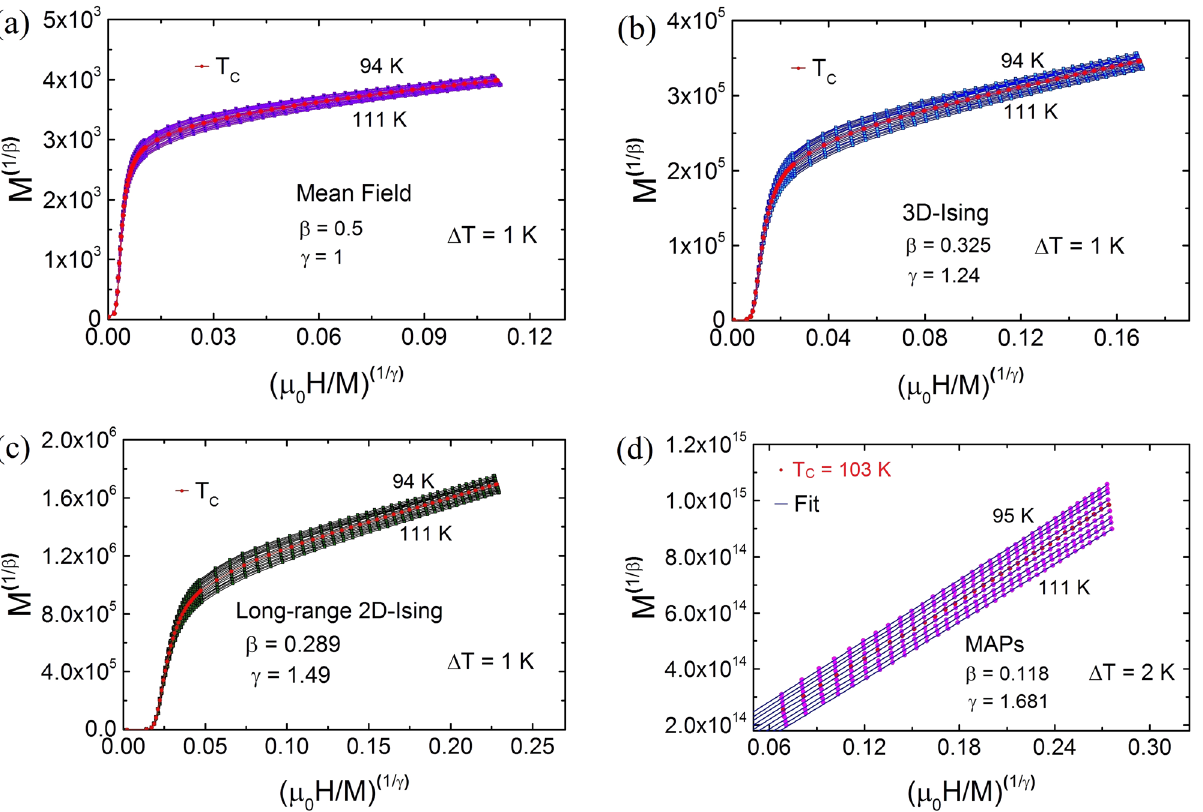
Figure 4. Isotherms of M 2 vs. µ 0 H/M for 94 K ≤ T ≤ 111 K ( | ǫ | ≤ 0.1 ) with ( a ) the Arrott plot (mean-field theory), which shows non-linear or non-mean-field type behavior even in higher magnetic field with positive slopes corresponding to the second-order phase transition. ( b ) MAPs for 3D-Ising with short-range interaction ( c ) MAPs for 2D-Ising model with Long-range interaction and ( d ) MAPs of M–H curves with β = 0.118 and γ = 1.681 in TL-LSMO-0.3. Solid lines are corresponding to the fits by the Eq. (11). (Figures have been drawn using OriginPro 2015 software).